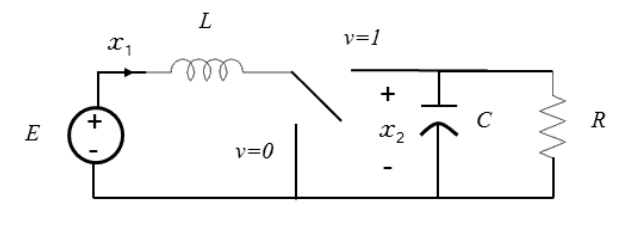
Figure 1. Boost power converter